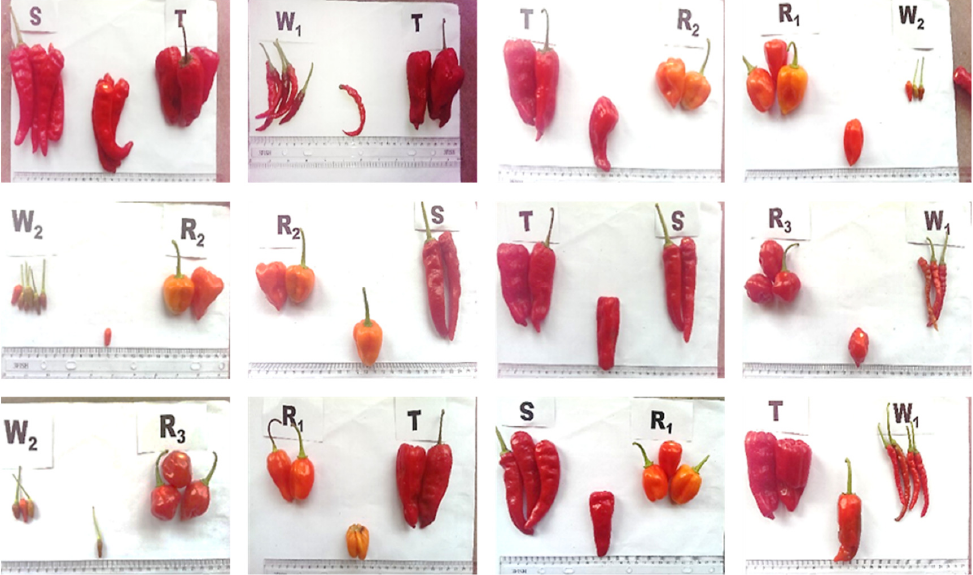
Figure 2. F 0 hybrid